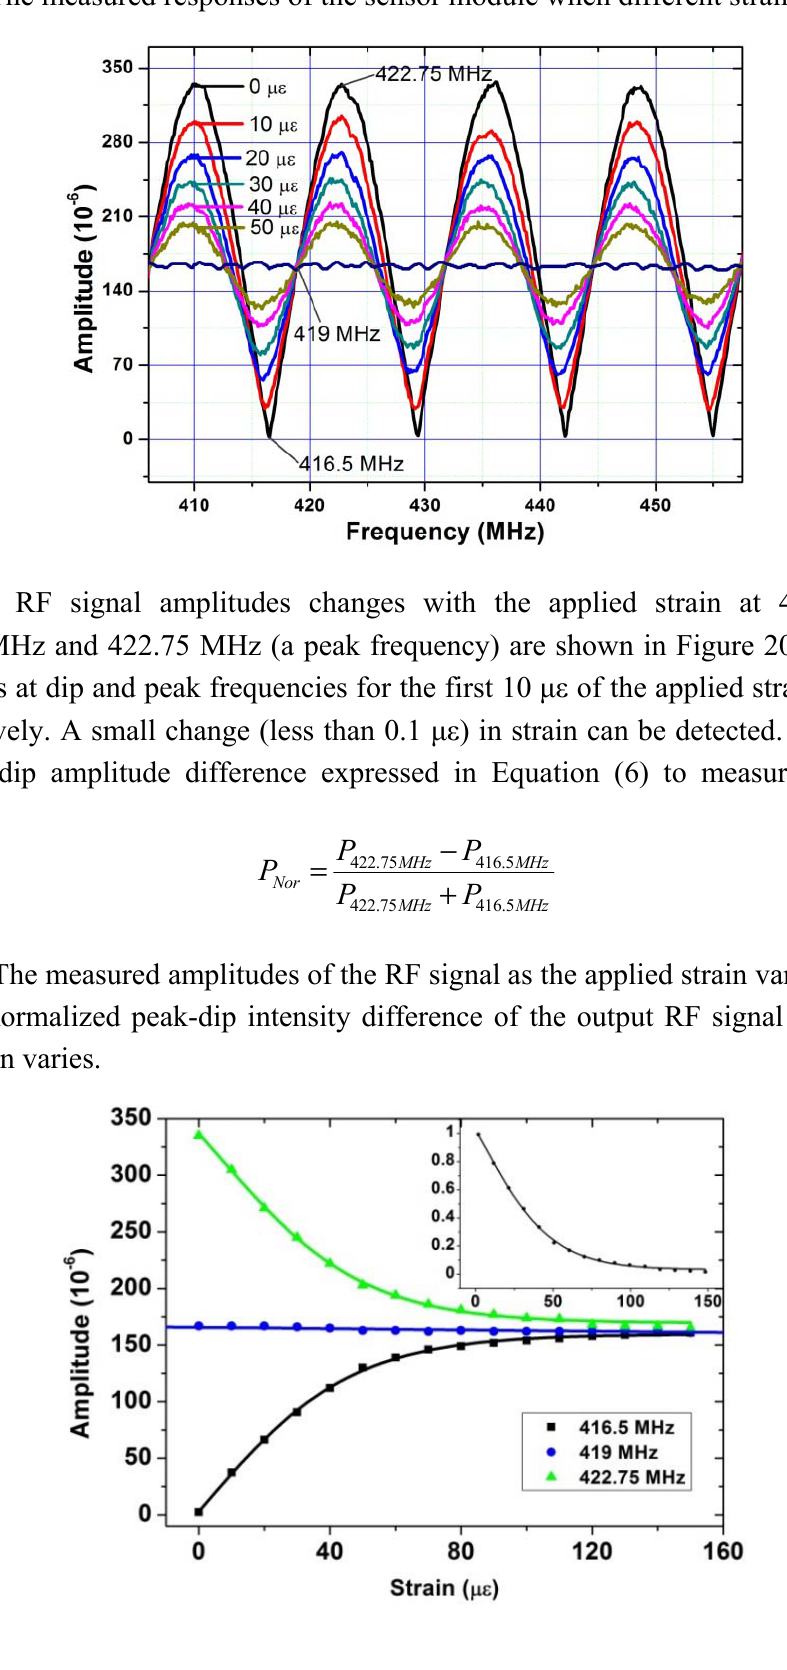
Figure 19. The measured responses of the sensor module when different strains are applied.